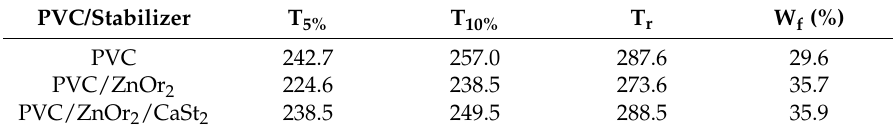
Figure 5. The TGA curves of PVC stabilized with various thermal stabilizers. Table 1. The TGA results of pure PVC and PVC stabilized with various thermal stabilizers.